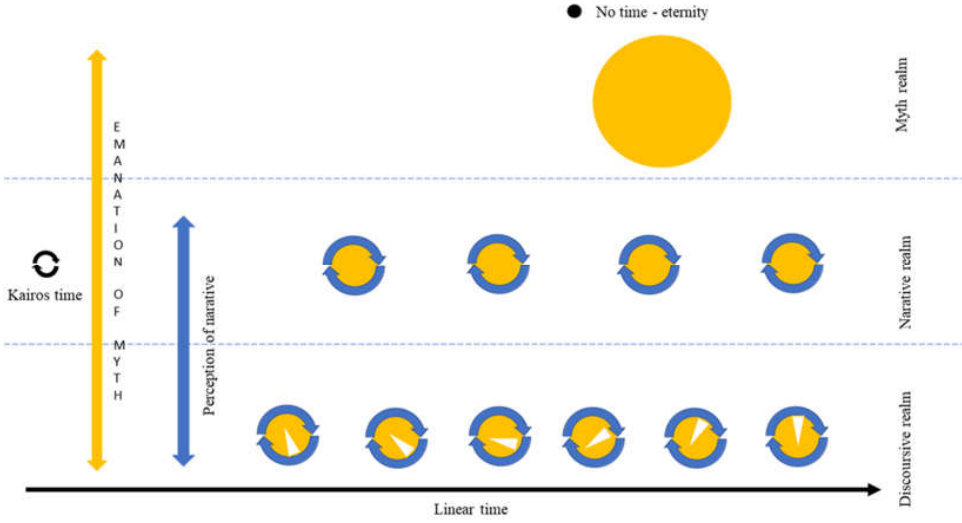
Figure 1. Explanation of the basis of myth–narrative–discourse interactions.